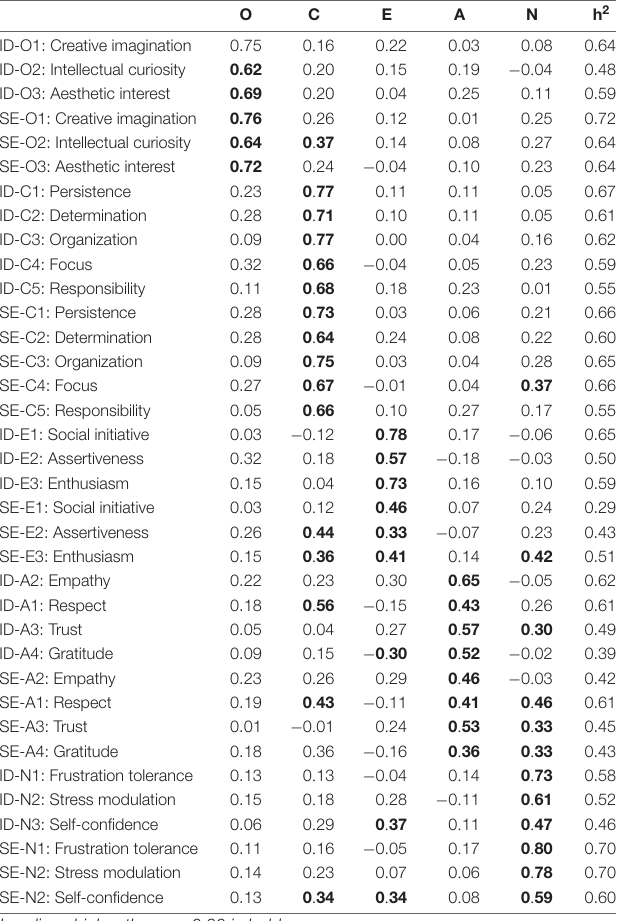
TABLE 6 | Joint principal component analysis of person-centered identity and self-efficacy scales: Standardized loadings and communality (h 2 ) to indicate total variance